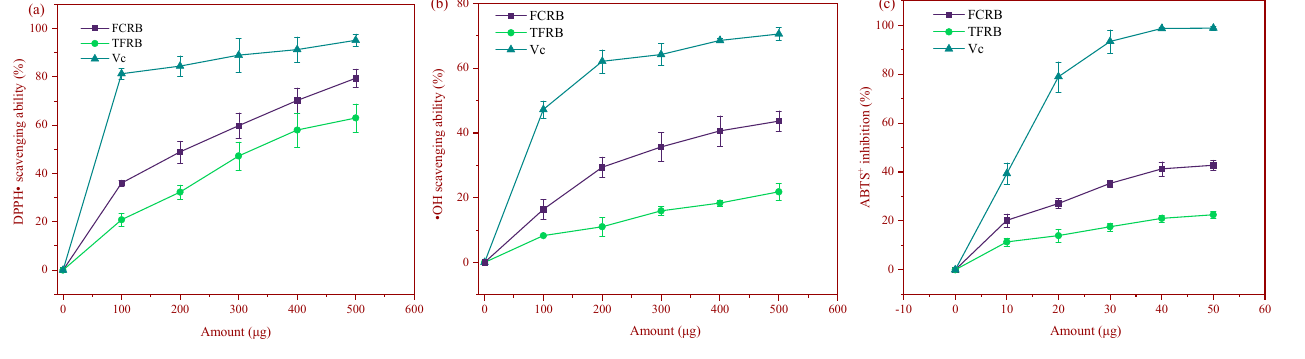
Figure 1. Chemical antioxidant capacity of FCRB or TFRB in vitro. ( a ) Scavenging ability of DPPH• by each fermented beverage; vitamin C (Vc) was used as the positive control. ( b ) Hydroxyl radicals scavenged by FCRB or TFRB. ( c ) ABTS + radical scavenging activity of FCRB and TFRB. All data are means ± SD for three measurements.